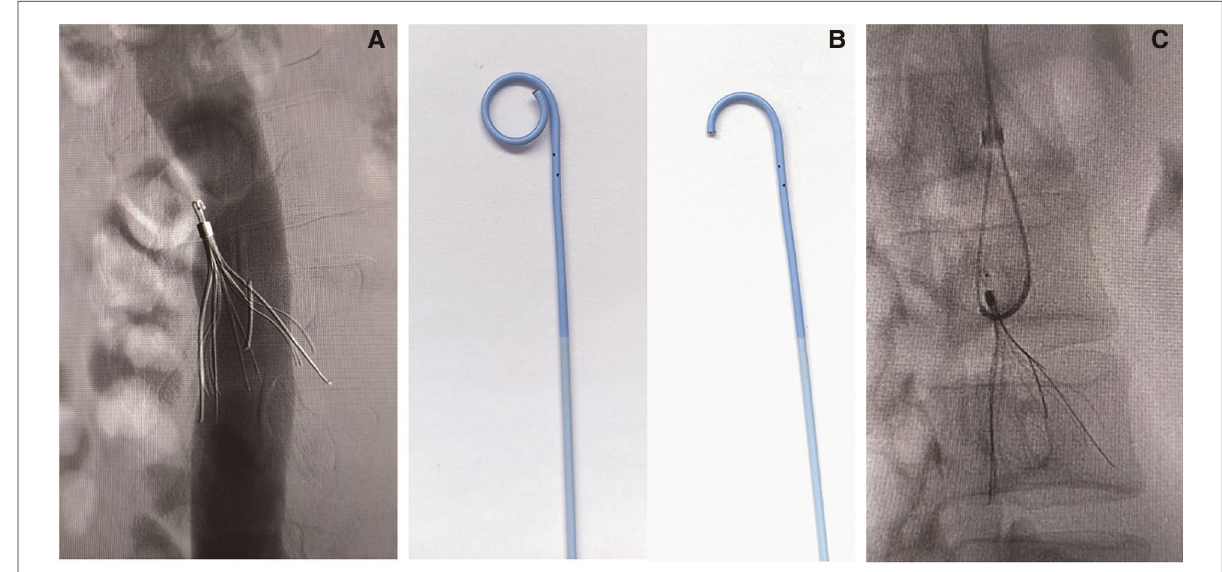
FIGURE 1 ( A ) The attachment of the Celect fi lter retrieval hook to the wall of the inferior vena cava, the surrounding proliferative tissue, and a broken pedicle. ( B ) The shape of the pigtail catheter after the removal of the tip. ( C ) Modi fi ed loop-snare